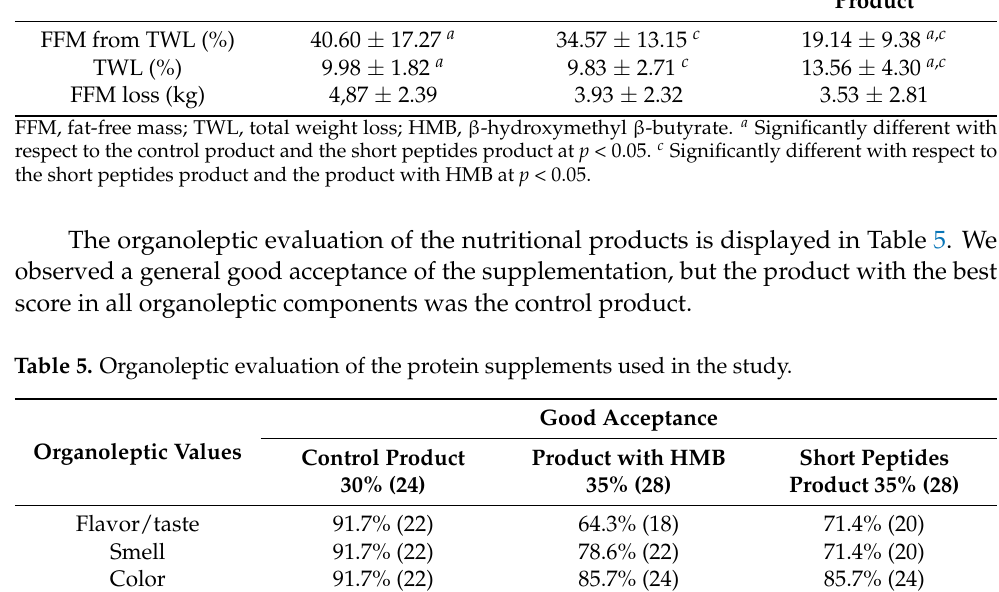
Table 4. Comparison between different nutritional products. Parameters